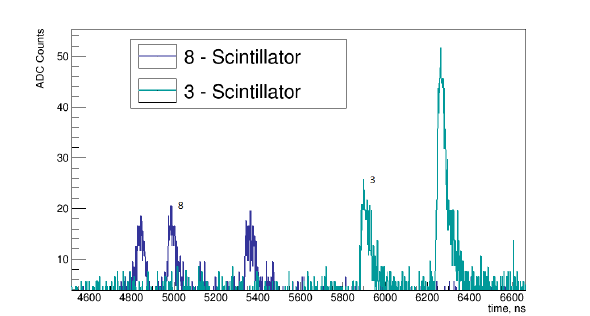
Figure 4. SE from H10T data. Figure 7. Unusual event from HT data.